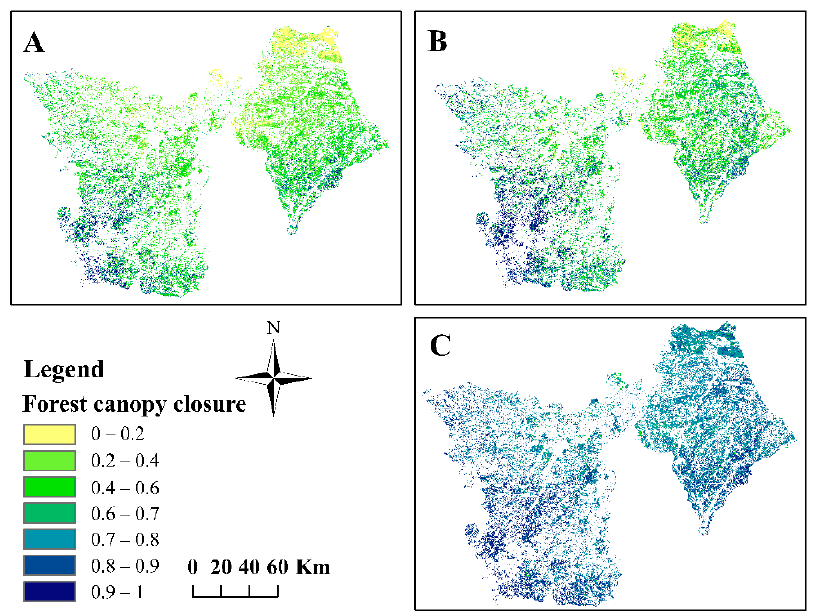
Figure 5. CC inversion results obtained using the Li–Strahler geometric-optical ( A ), multiple stepwise regression ( B ) and back propagation neural network ( C ) models.